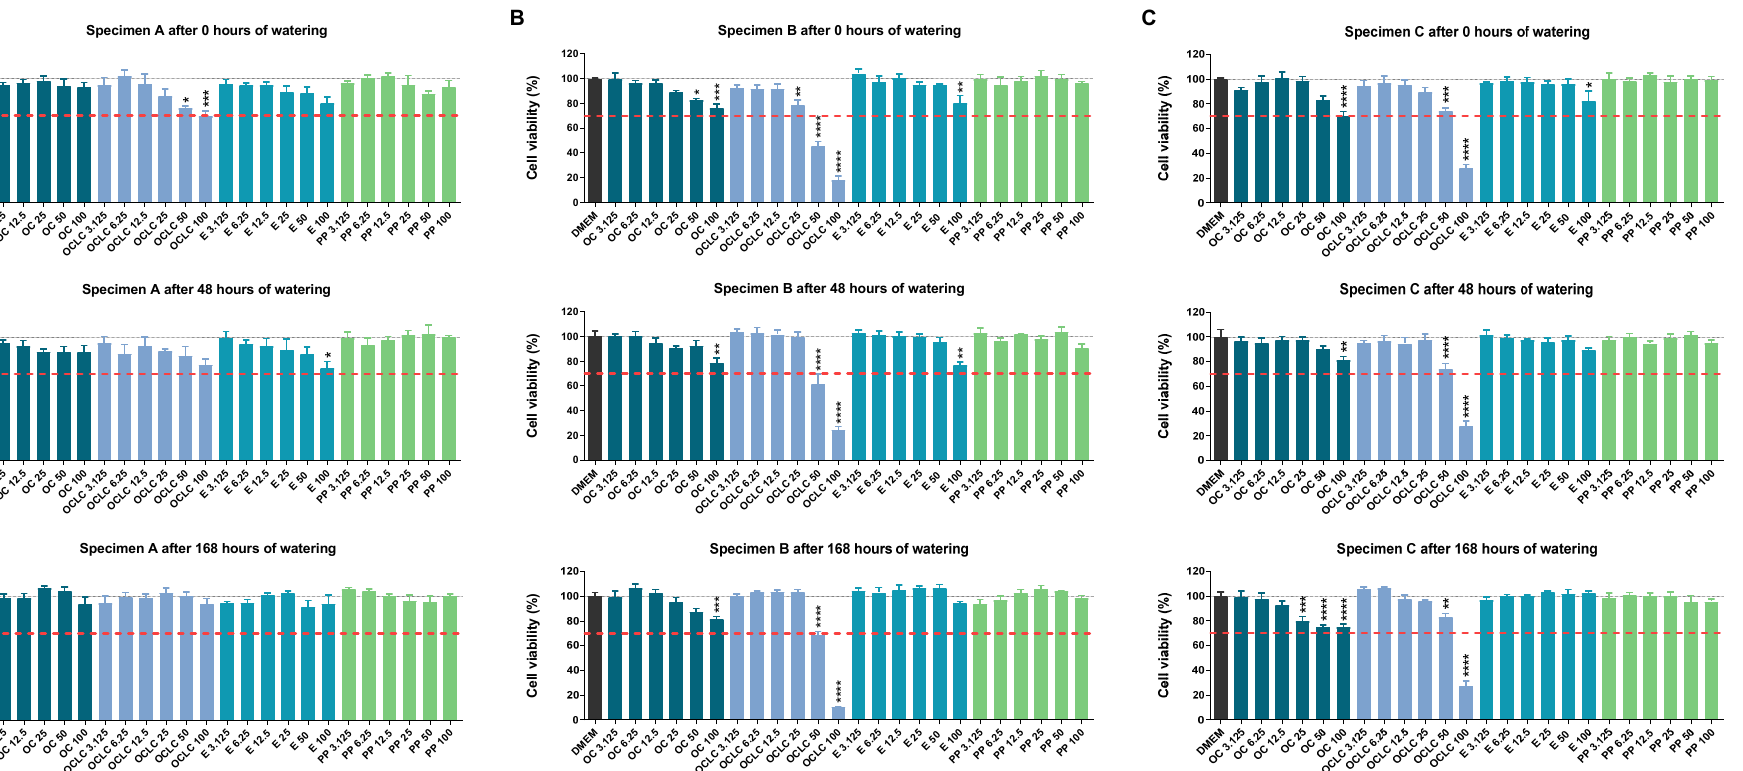
Figure 2. Viability of A549 cells measured by WST-1 assay after incubation with eluates from ( A ) test specimens A (15 mm × 0.5 mm), ( B ) test specimens B (50 mm × 1.0 mm) or ( C ) test specimens C (50 mm × 3.0 mm) of different compositions (OC, Orthocryl ® ; OCLC, Orthocryl ® LC; E, Loctite ® EA 9483; PP, polypropylene) and previous watering conditions. The test specimens were stored in distilled water at room temperature for 0, 48 or 168 h followed by a 24 h storage in cell culture medium (DMEM, Dulbecco’s Modified Eagle Medium) under shaking conditions. The DMEM eluates were used undiluted (100%) or diluted (50, 25, 12.5, 6.25, 3.125%) for a 24 h incubation of A549 cells followed by determination of cell viability using the WST-1 assay. Percentages represent comparison with cells treated with DMEM vehicle control (set to 100%). The data are mean values ± SEM of n = 3–4 per group. * p ≤ 0.05, ** p ≤ 0.01, *** p ≤ 0.001, **** p ≤ 0.0001 vs. DMEM control; one-way ANOVA with Dunnett’s post hoc test. The dashed red line shows the 30% deviation of the treatment groups from the control value (DMEM group).